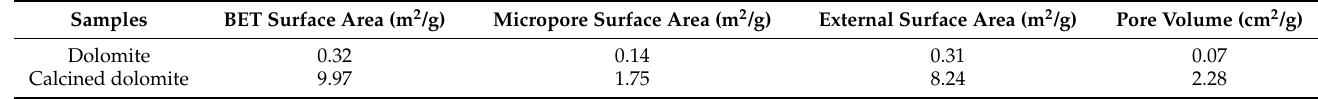
Figure 7. Schematic diagram of the two-stage catalytic pyrolysis reactor.